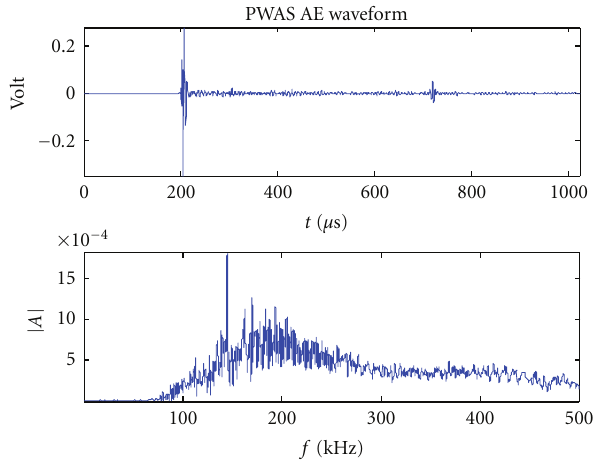
Figure 10: PLB detection on steel plate using coaxial cable wired